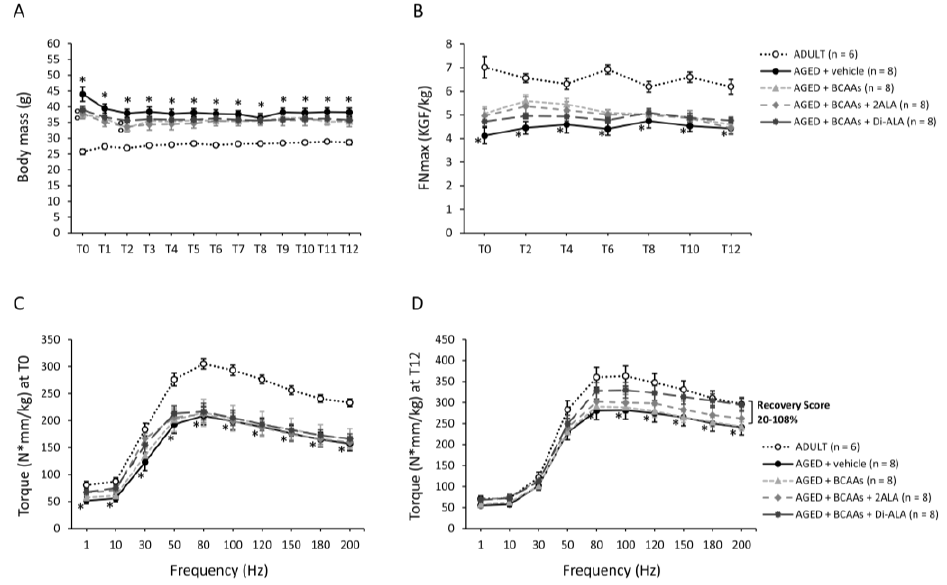
Figure 1. Data for body mass (BM; g), monitored once a week (from T0 to 12) in all mice cohorts (ADULT mice and AGED mice treated with vehicle, BCAAs, BCAAs + 2ALA or BCAAs + Di-ALA), and forelimb grip strength, measured once every two weeks and normalized to each animal’s BM (FNmax; KGF/kg), are shown in ( A , B ), respectively. All values are expressed as mean ± SEM for the number of mice indicated in brackets. For both indices, a statistically significant difference was found via an unpaired Student’s t-test for AGED mice + vehicle vs. ADULT mice at all time points (*; 0.0001 < p < 0.005). For BM, a statistically significant difference was found among AGED mice groups via a one-way ANOVA at T0 and T2 (F < 3.4, p = 0.03). Dunnett’s post hoc test, used to compare each mixture-treated group to the vehicle group, is as follows: ◦ vs. AGED + vehicle (0.02 < p < 0.04). ( C , D ) show values for hind limb plantar flexor torque produced at increasing frequencies (1–200 Hz), normalized to each animal’s BM (N · mm/kg), obtained from all mice groups at T0 and T12, and expressed as mean ± SEM for the number of mice indicated in brackets. A statistically significant difference was found via an unpaired Student’s t-test for AGED + vehicle vs. ADULT mice for T0 at all frequencies (*; 0.0005 < p < 0.01) and for T12 at frequencies from 80 to 200 Hz (0.02 < p < 0.05). No statistically significant differences were found among AGED mice groups via a one-way ANOVA followed by Dunnett’s post hoc test. The range of recovery scores towards ADULT values, calculated at T12 for mice treated with BCAAs + 2ALA or Di-ALA, is indicated at the right end of the lines.